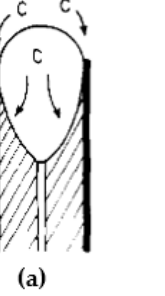
Figure 7. Proposed mechanism for a carbon filament formation over a metallic catalyst: ( a ) filament formation, ( b ) coking .